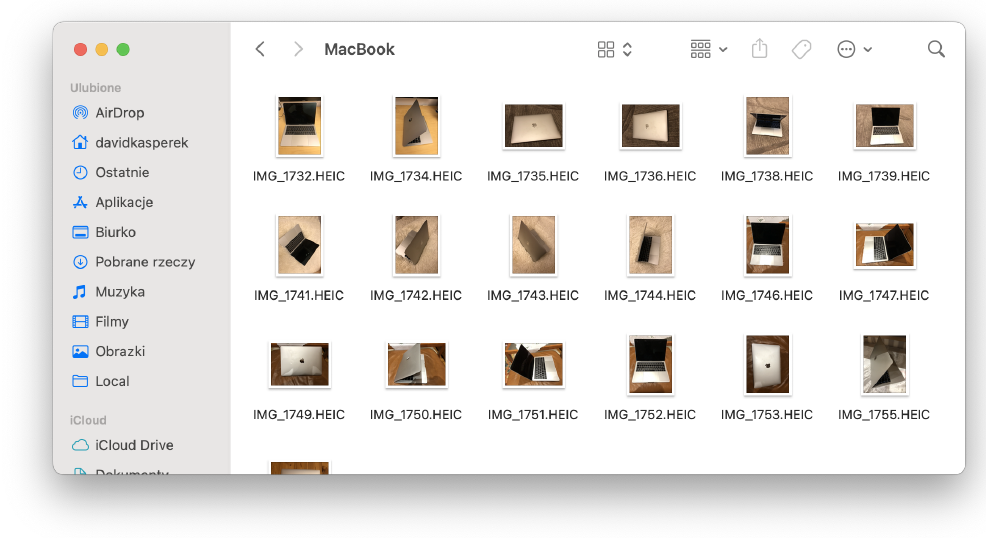
Figure 6. Photos of category ‘MacBook’ form the training data in ‘ClassifierData’.